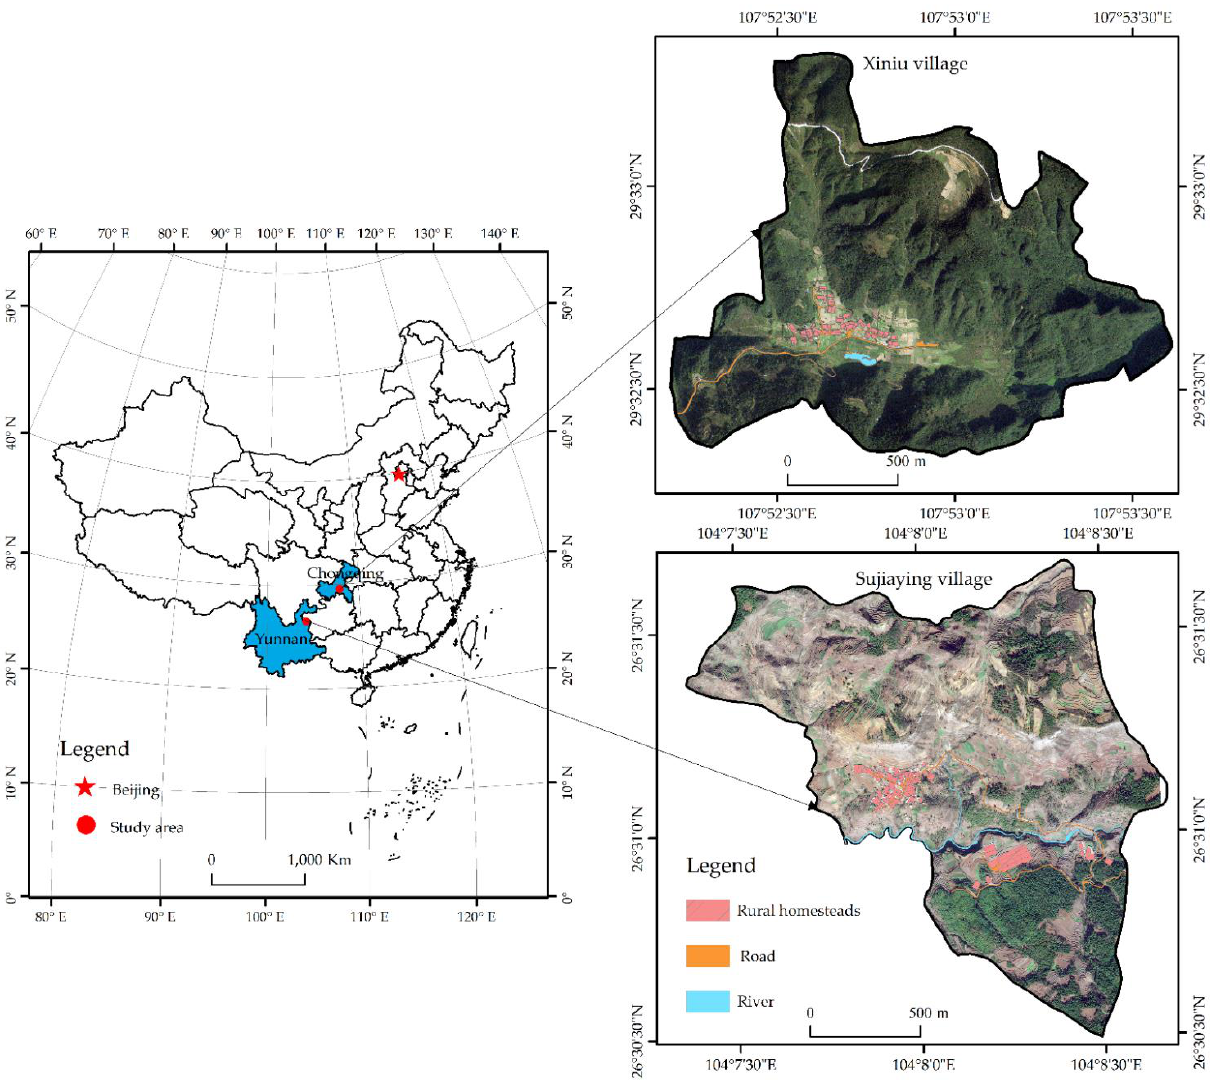
Figure 2. Location of the case area .